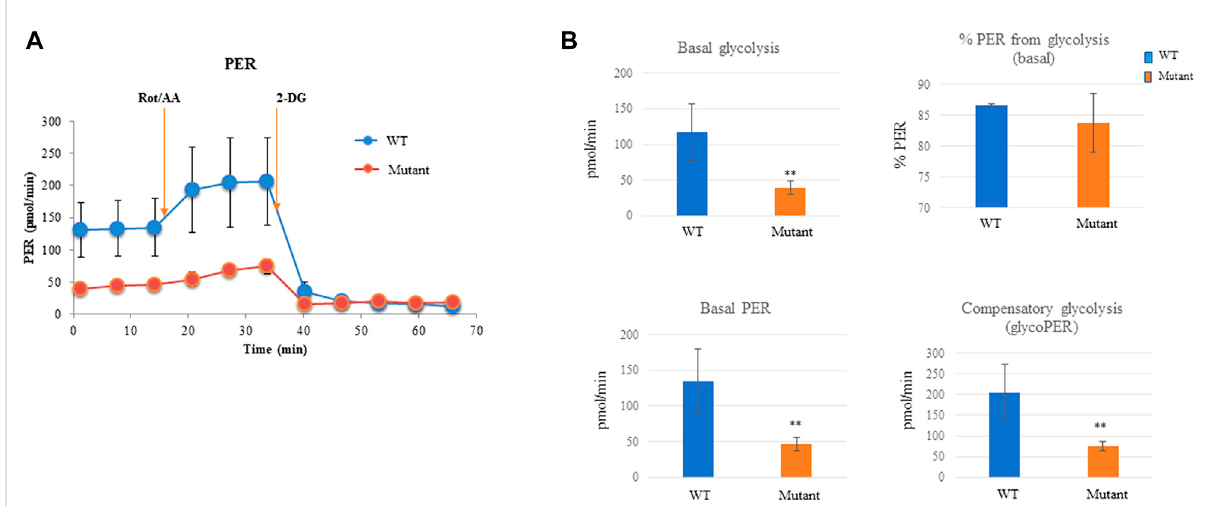
FIGURE 4 PGAM2-K176R mutation decreases the glycolytic rate. For measuring the glycolytic rate, C2C12 cells were seeded into 96-well Seahorse cell culture plates and cultured overnight. The Seahorse XFe96 Extracellular Analyzer was used to record three basal rate measurements, followed by injections with Rot/AA according to the manufacturer ’ s protocol. Data were automatically generated by the Seahorse XF Glycolytic Rate Assay Report Generator and Wave program. (A) One representative mitochondrial respiration curve from seven independent experiments is shown. (B) PGAM2 K176R/K176R mutant cells exhibited a reduced basal glycolytic rate, basal PER, and compensatory glycolysis. No signi fi cant difference was observed in % PER from glycolysis (basal) between WT and PGAM2 K176R/K176R mutant cells. Data are expressed as the mean ± SD. n = 6 wells per group. ** p < 0.01 vs